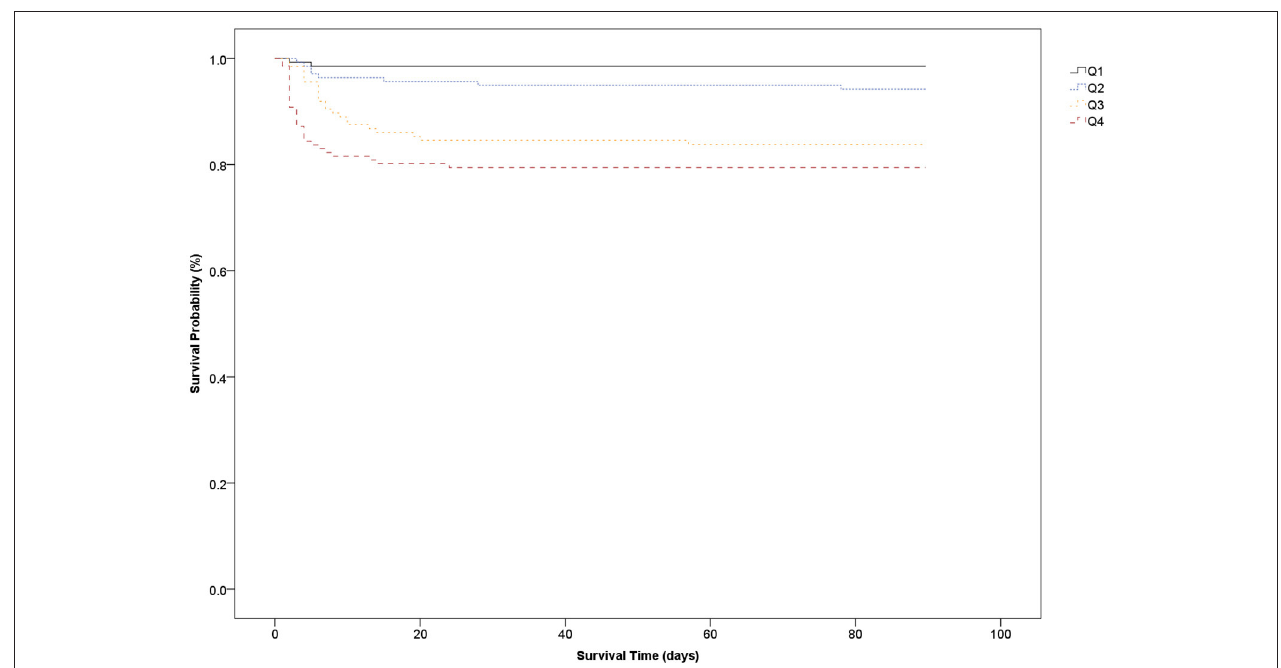
FIGURE 2 | The Kaplan–Meier survival analysis based on the glucose/potassium ratio.